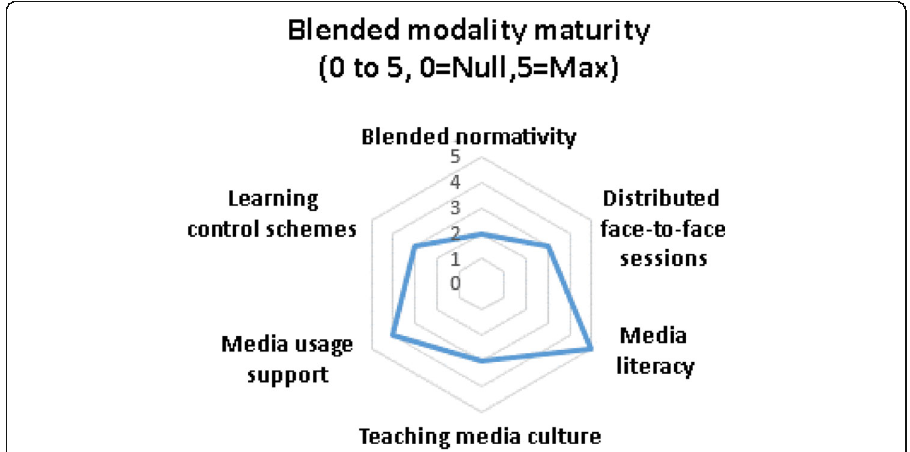
Fig. 2 Hypothetical case of multidimensional maturity for blended